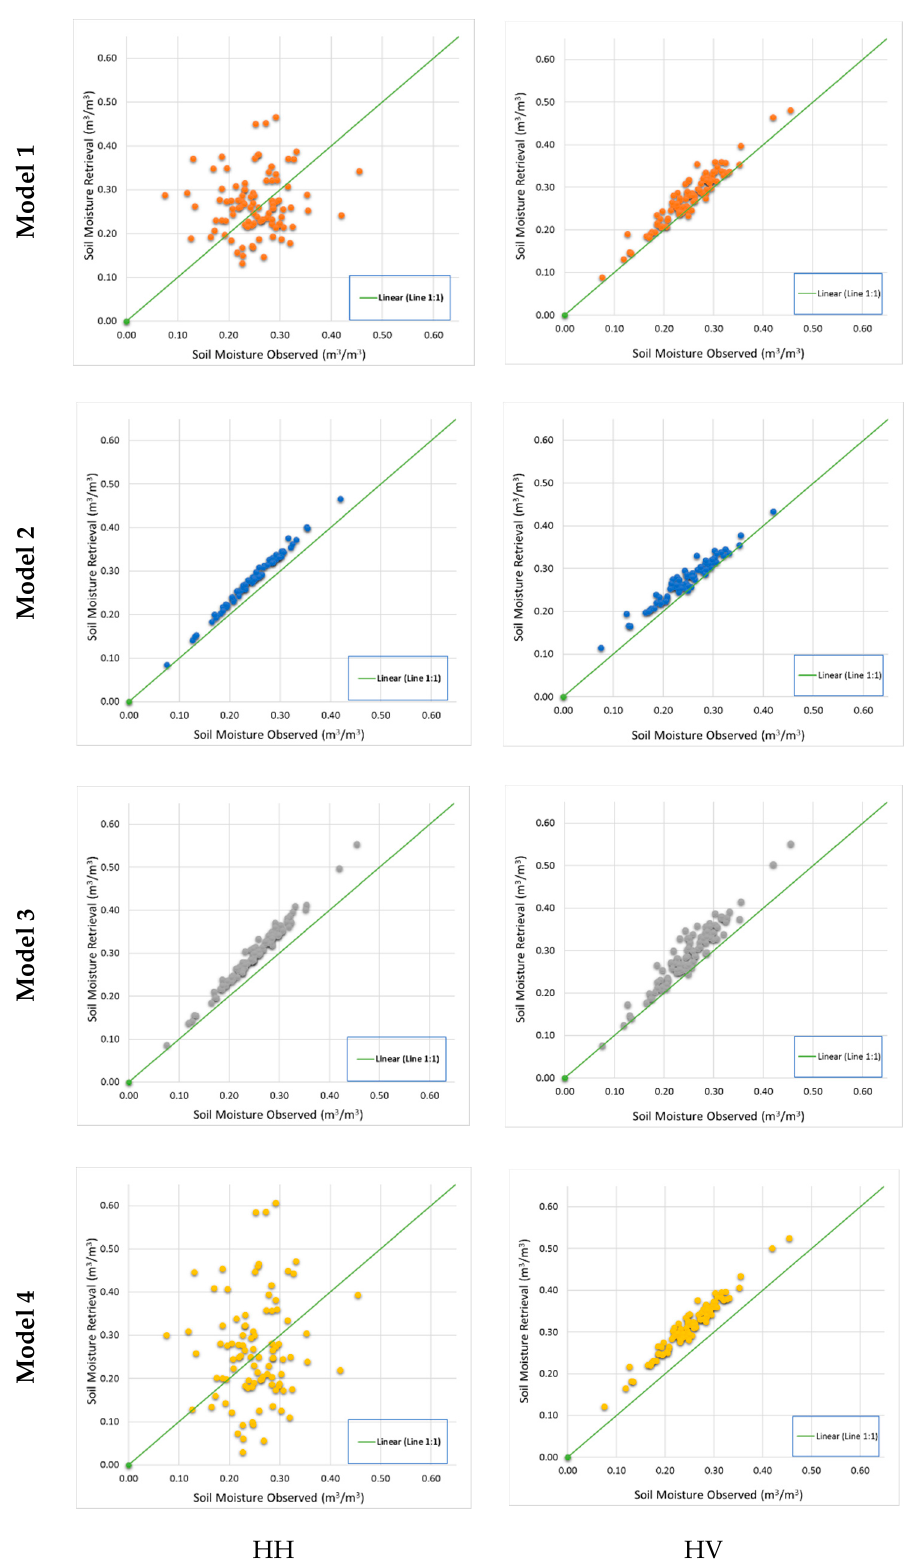
Figure 3. Scatterplots showing the observed and retrieved soil moisture data from an oil palm crop under both HH ( left ) and HV ( right ) polarization in different models in the L band.